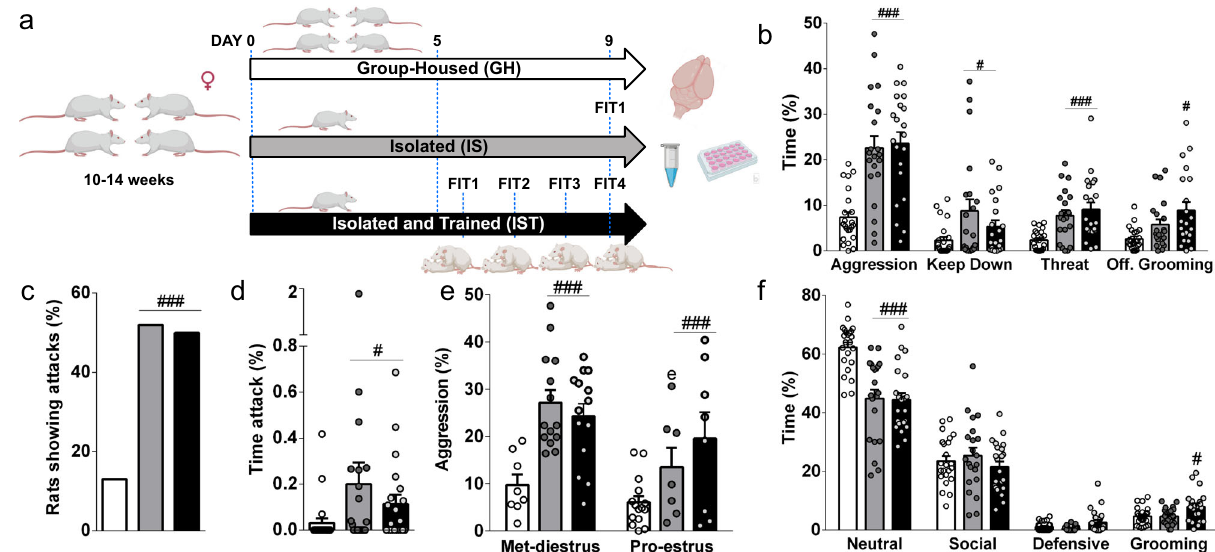
Fig. 1 Social isolation and training reliably enhance aggression in female Wistar rats, independently of the estrous cycle. a Scheme illustrating the animal groups and experimental timeline. Female Wistar rats were kept either group-housed (GH) or socially isolated (IS). After 5 days of social isolation, isolated and trained (IST) females were exposed to three consecutive female intruder tests (FIT1 to FIT3), i.e., to aggressive encounters with an unknown same-sex intruder. Black bars correspond to data from FIT4 (test). Partially drawn using https://biorender.com. b Both IS and IST rats showed increased total aggression (one-way ANOVA followed by Bonferroni F (2,63) = 16.26, p < 0.0001), keep down (Kruskal – Wallis test followed by Dunn ’ s H 3 = 6.69, p = 0.035), threat ( H 3 = 18.98, p < 0.0001) and offensive grooming ( H 3 = 10.8, p = 0.005). c IS and IST females engaged more in attacks (Chi-squared test, X 2 = 40.81, p < 0.0001), and d spent a higher percentage of time attacking ( H = 8.8, p = 0.012) than GH females. e IS females in the proestrus and estrus 3 (Pro-estrus) phase of the estrous cycle displayed less aggressive behavior than metestrus-diestrus (Met-diestrus) females (two-way ANOVA followed by Bonferroni; factor housing: F (2, 60) = 12.7, p < 0.0001; estrous cycle: F (1, 60) = 8.5, p = 0.005; housing × estrous cycle: F (2, 60) = 1.54, p = 0.22). f IST and IS females compensated their increased aggression with decreased neutral behaviors ( F (2, 63) = 18.76, p < 0.0001), only IST females spent more time self- grooming (F (2, 63) = 5.79, p = 0.005). All data are shown as mean + SEM. # p < 0.05, ## p < 0.001, ### p < 0.001 vs GH; e p < 0.05 vs met-diestrus. GH: n = 23; IS: n = 21; IST: n =